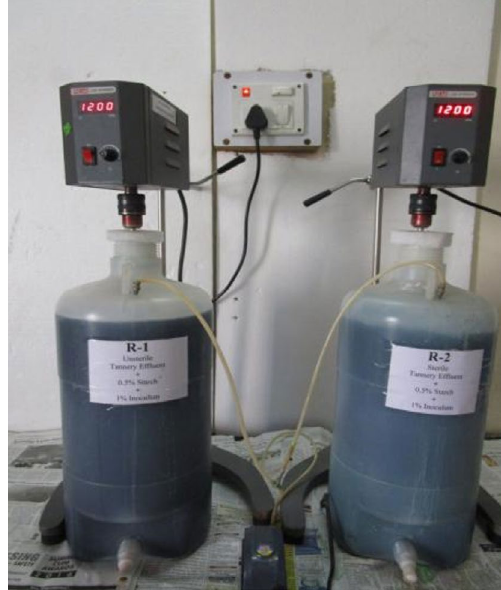
Fig. 1. Bioreduction of chromium contaminated tannery